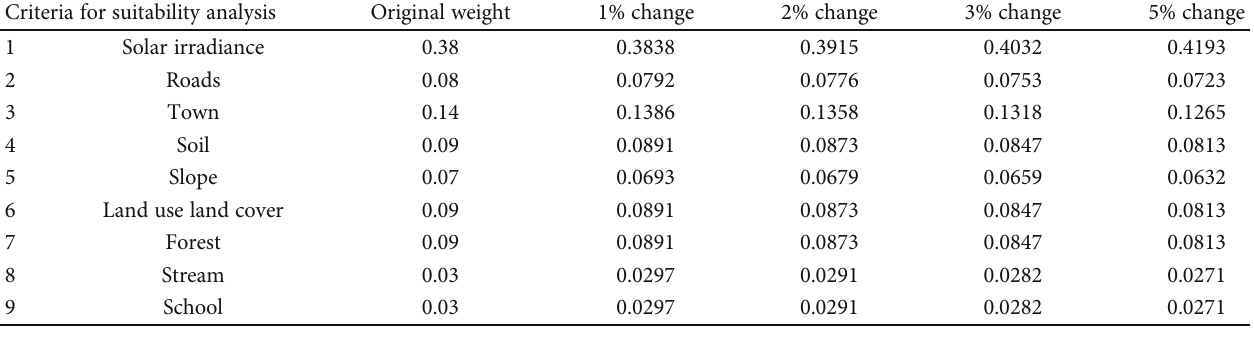
Table 14: Suitability area percentage of sensitivity analysis.